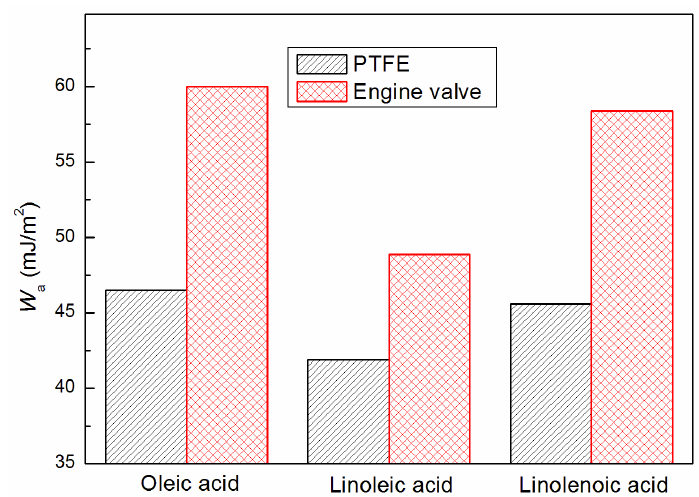
Figure 6. The values of the adhesion work ( W a ) for oleic, linoleic, and linolenic acids to the PTFE and engine valve surface.